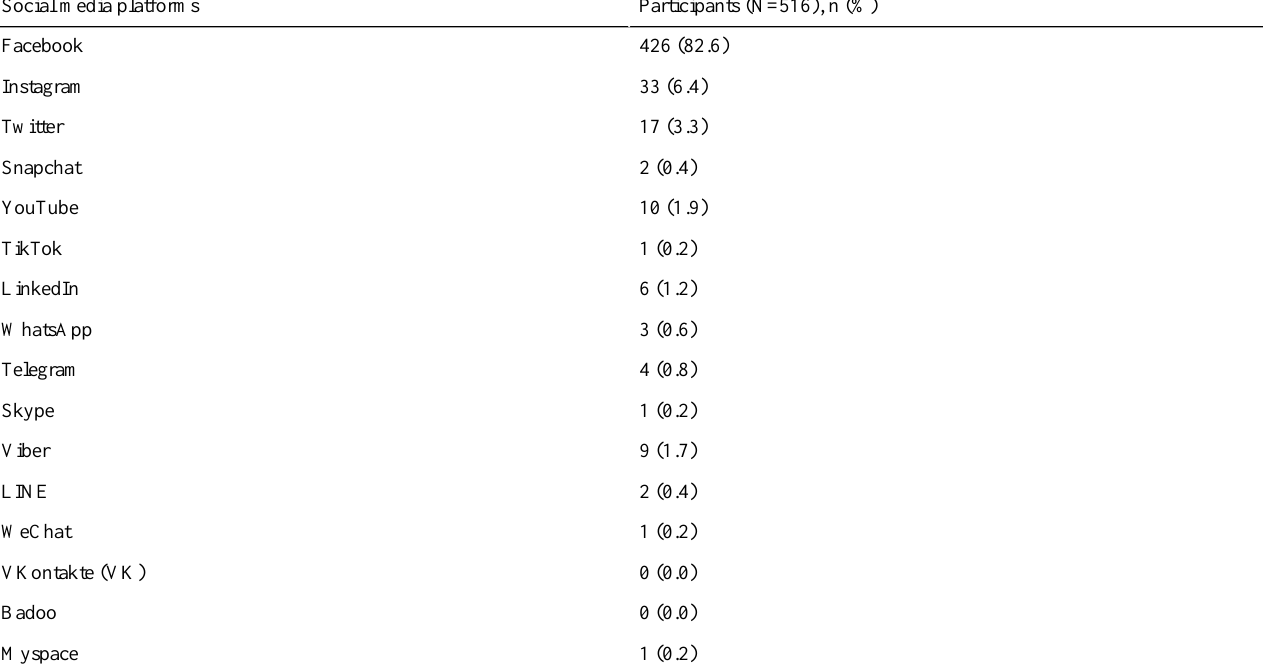
Table 2. The social media platforms used to get news about the coronavirus